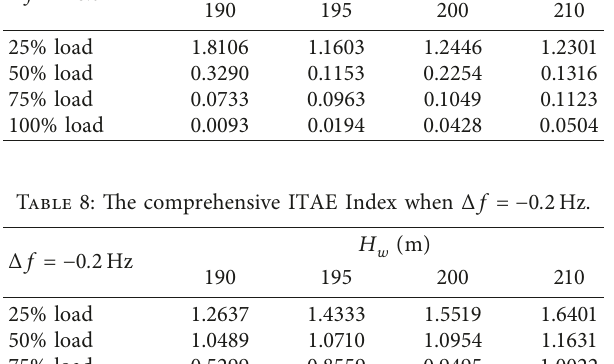
Table 7: The comprehensive ITAE Index when Δ f � − 0 . 5Hz. Δ f � − 0 . 5Hz